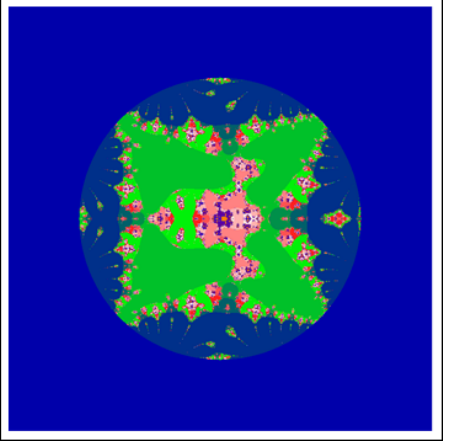
Figure 19. J-set via F-iteration for sin ( z 4 ) + 0.55 with image visual time = 61.23 s.